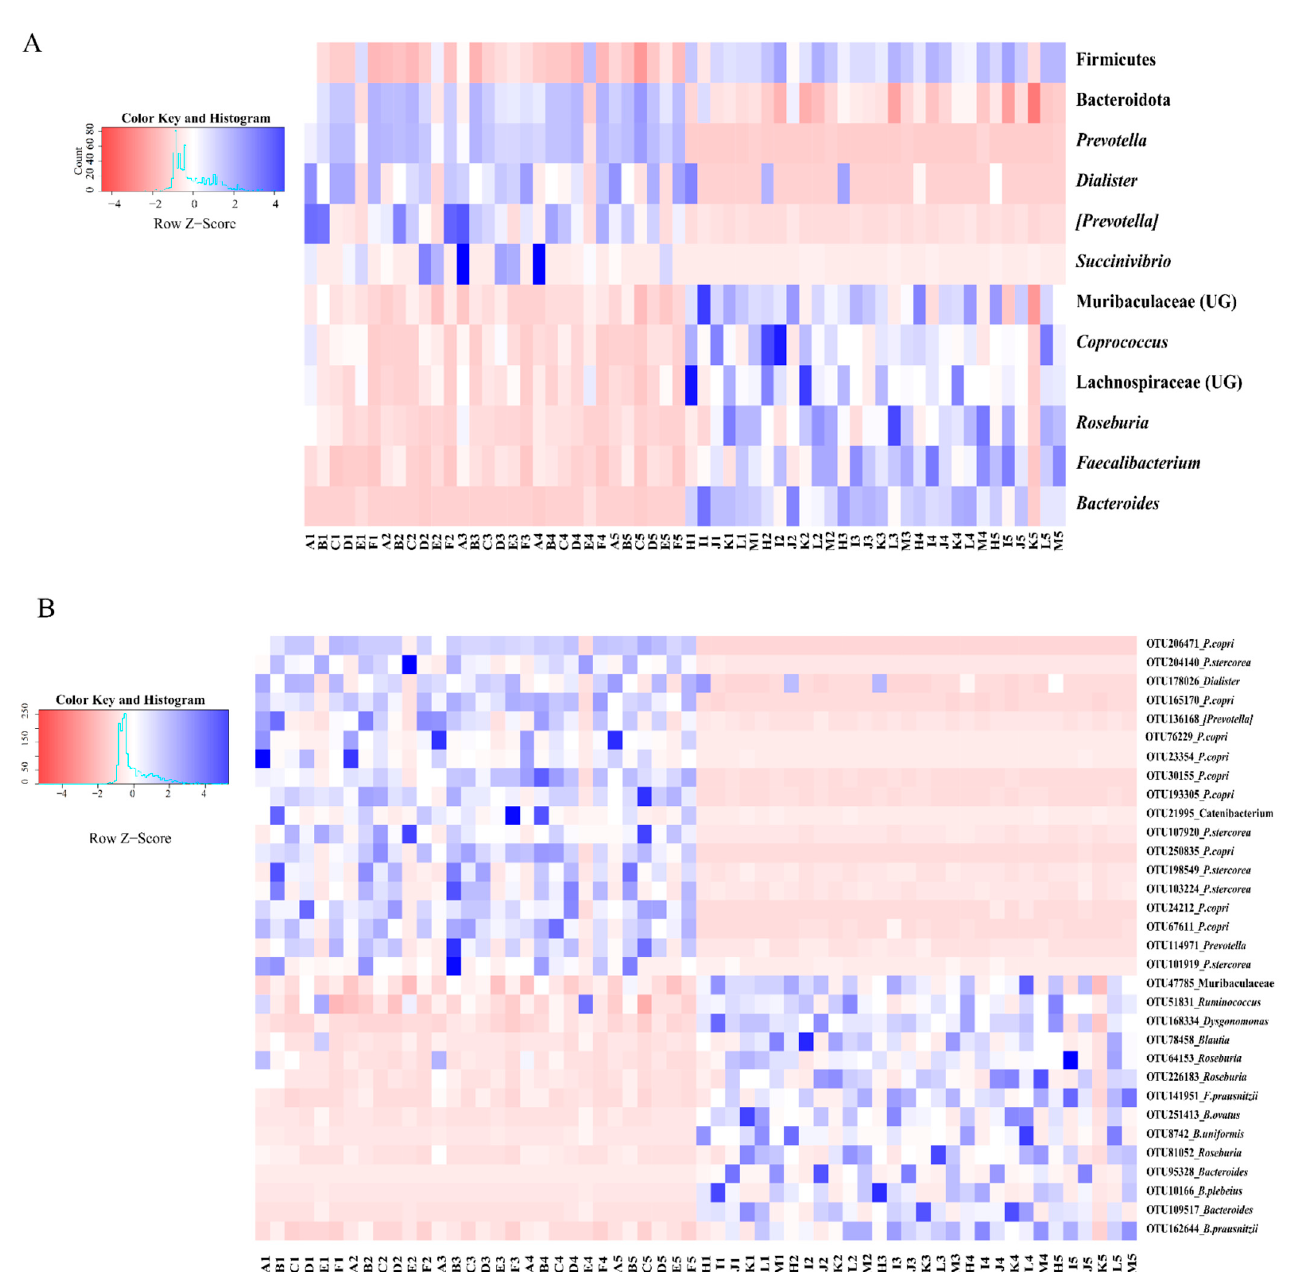
Figure 3. The comparison of dominant gut microbiota between Pakistani and Chinese participants at the phyla level, genus level ( A ), and OTU level ( B ). We picked phyla with average relative abundance >0.1% and genera with average relative abundance >1% individually. At OTU level, relative abundance ranked top 10 were selected. Only microbiomes distributed significantly different using Mann–Whitney U test between Chinese and Pakistanis were presented ( p < 0.05).